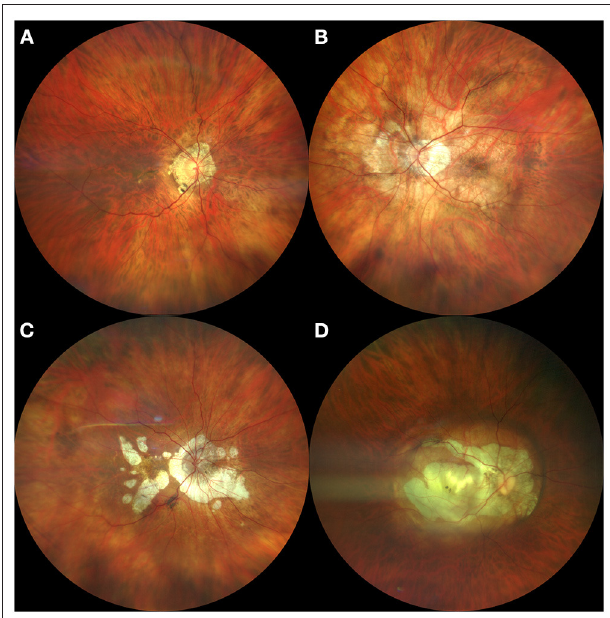
FIGURE 1 | Summary of different myopic atrophic retinal changes. (A) Fundus tessellation; (B) Diffuse chorioretinal atrophy; (C) Patchy chorioretinal atrophy; (D) Complete macular